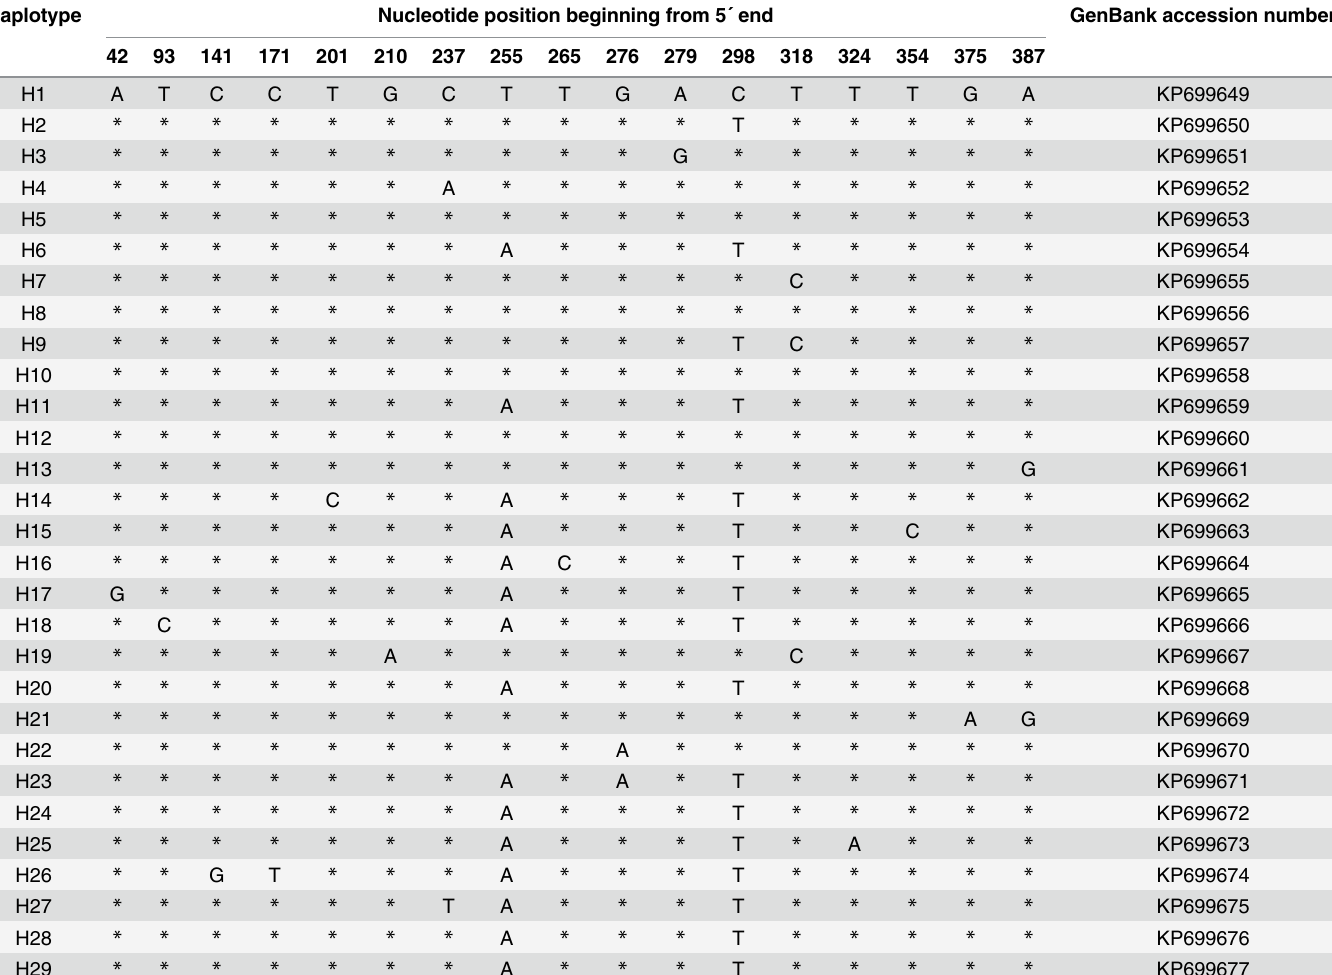
Table 3. Variable Position of 29 Haplotypes of COI in Macridiscus multifarius .